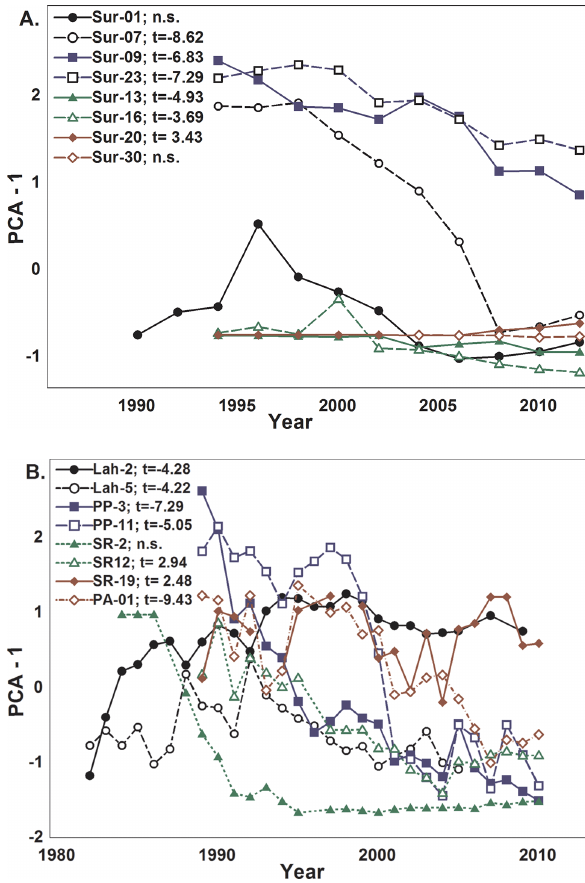
Fig. 14. Modified DCA plots: (A) Surtsey; (B) Mount St. Helens. Change units “a” are the overall Euclidean distance between early and final plots; “b” is the percentage of this change that occurred in the last 10 years of the record. Lower percentages indicate slower development in recent years.